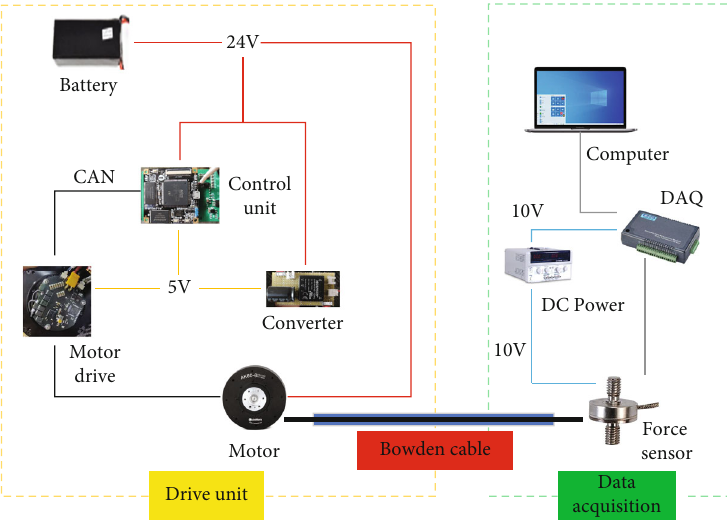
Figure 11: The schematic diagram of the fl exible exoskeleton electrical